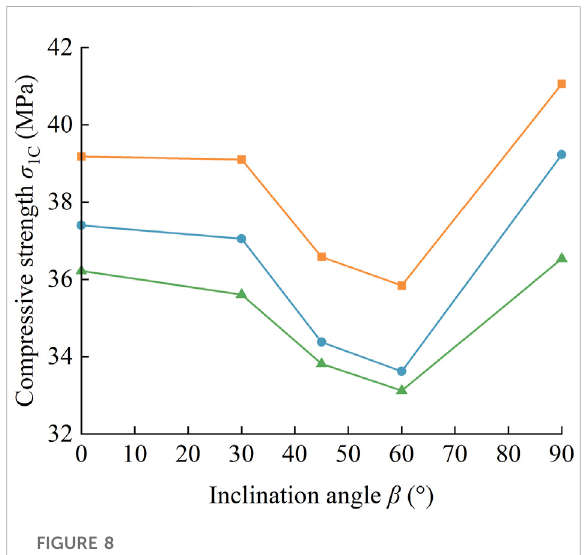
FIGURE 8 Effect between different width-to-length ratios and inclination angles on compressive strength of numerical samples containing opening fl